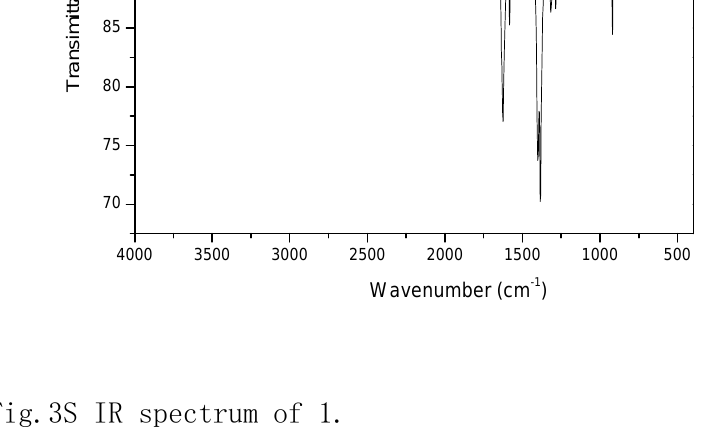
Fig.3S IR spectrum of 1.